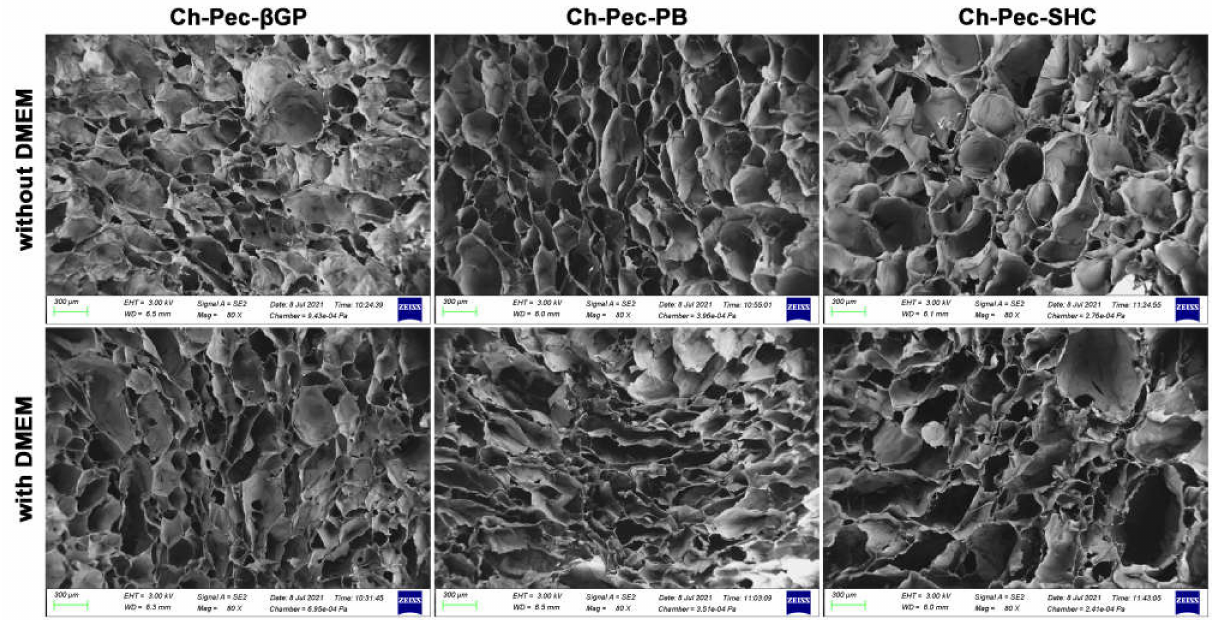
Figure 6. SEM investigation: morphological analysis of hydrogel formulations ( β GP-PB-SHC), with and without the addition of DMEM (magnification 80 × , scale bar 300 µ m).